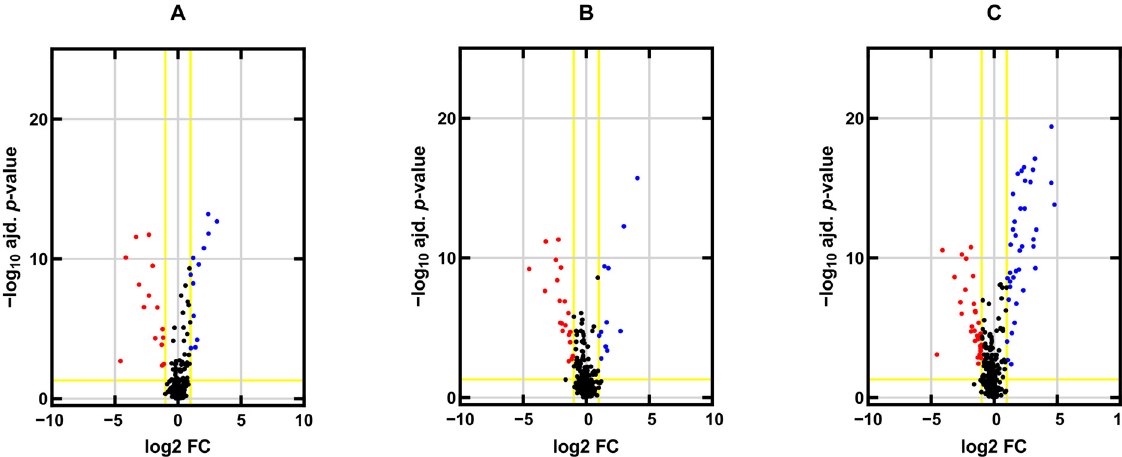
Figure 1. Differentially expressed miRNAs in CDDP-resistant vs. -sensitive TGCT cell lines. Differentially expressed miRNAs in three CDDP-resistant TGCT cell lines (H12.1D, 1411HP and 1777NRpmet) were compared with the CDDP-sensitive H12.1 cell line. Volcano plots represent comparisons of the mean log 2 FC of miRNA expression between the H12.1D and H12.1 ( A ), 1411HP and H12.1 ( B ) and 1777NRpmet and H12.1 ( C ) TGCT cell lines. Vertical lines correspond to twofold up- and down-regulation. Horizontal lines represent thresholds for the adjusted p value < 0.05. Blue and red points in the volcano plot represent twofold up- and down-regulated miRNAs, respectively, that were differentially expressed and statistically significant. Black points represent miRNAs whose expression changes were not statistically significant or did not show >2 FC in expression.